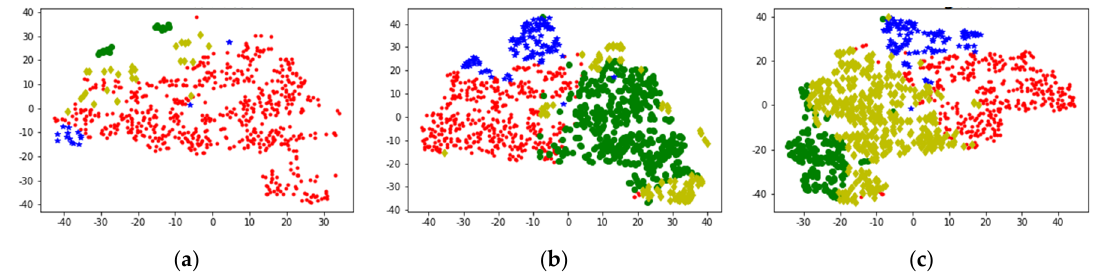
Figure 14. Clustering results visualization. ( a ) DBSCAN; ( b ) K-means++; ( c ) Multi-Clustering.